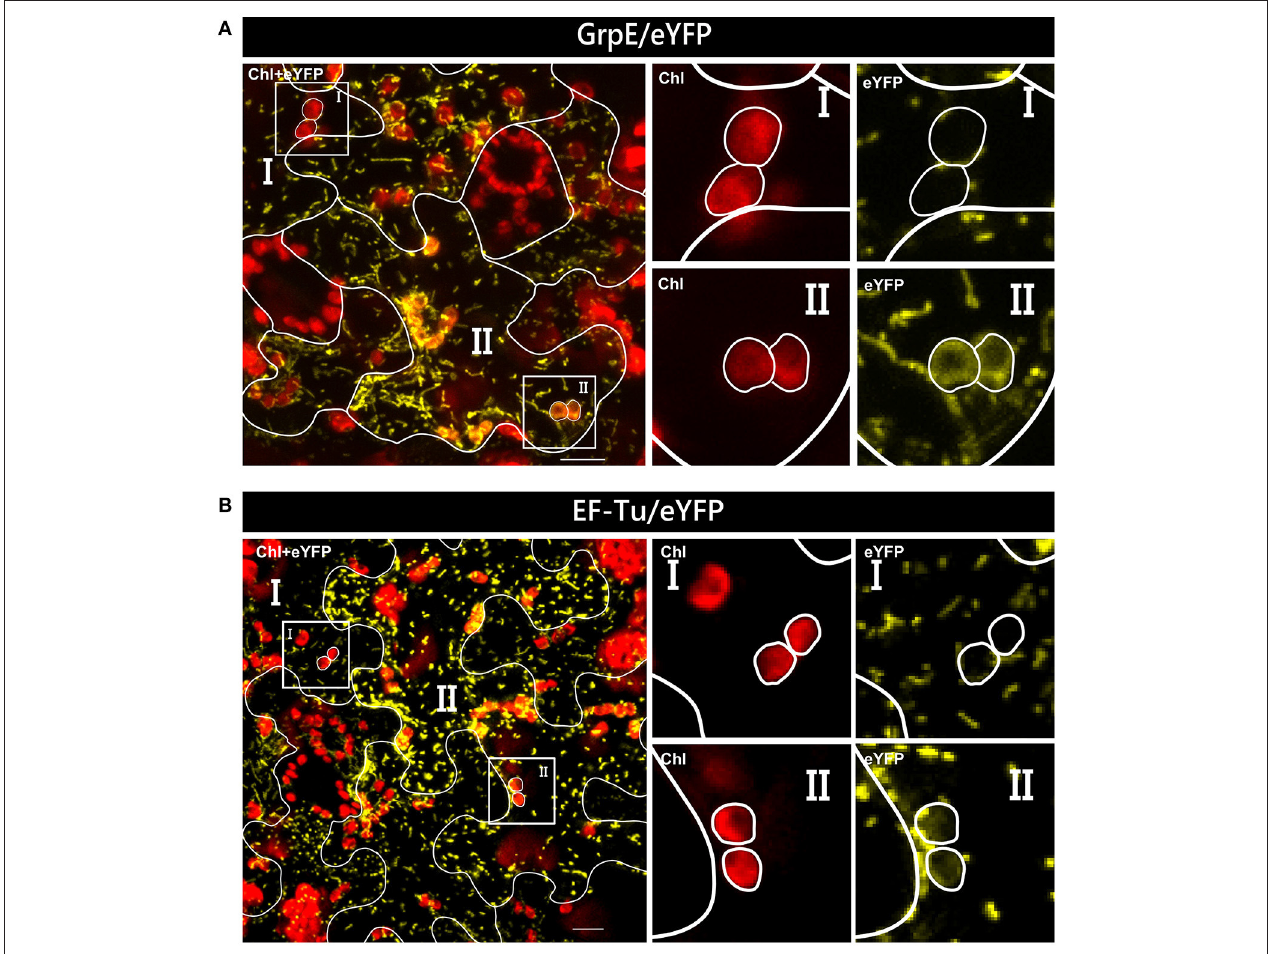
FIGURE 5 | Variable organelle targeting in different cells of Nicotiana benthamiana after Agrobacterium infiltration. Confocal laser scanning microscopy of the lower epidermis of Nicotiana benthamiana infiltrated with Agrobacterium tumefaciens strain GV3101 carrying constructs encoding GrpE/eYFP (A) or EF-Tu/eYFP (B) . In both instances, dual targeting of the reporter protein is observed only in cells with strong expression of the candidate constructs (II), not in those with low expression levels (I), which show solely mitochondrial accumulation. For further details see the legend of Figure 1